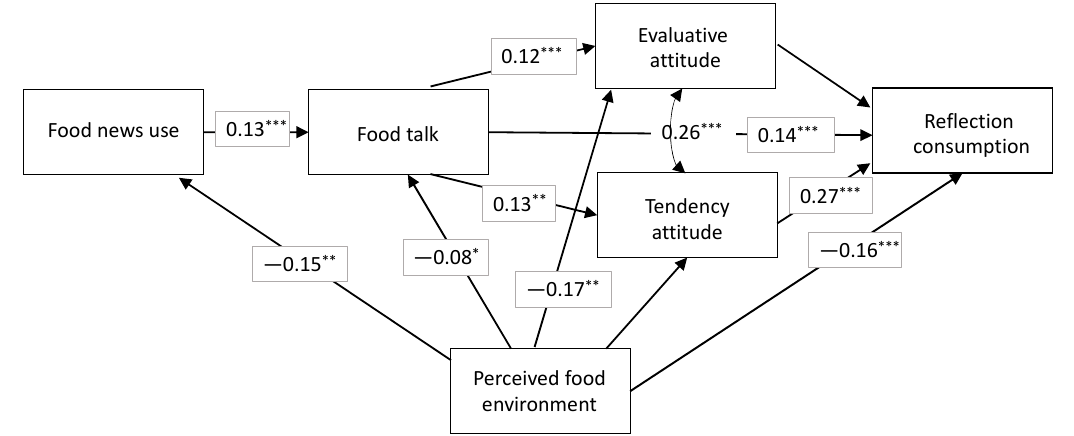
Figure 4. Path Analysis of the Food Environment Influence Using the CMM. Note: Statistics represent STDX standardized betas. * corresponds to p ≤ 0.05; ** corresponds to p ≤ 0.01; *** corresponds to p ≤ 0.001. Dotted paths are non-significant. N = 1435.